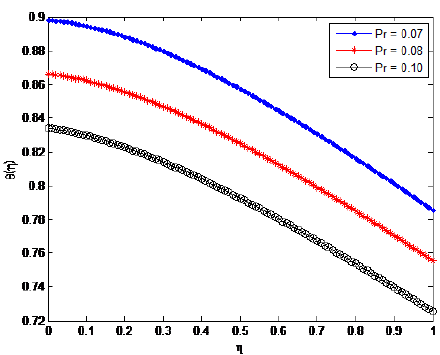
Figure 15. Influence of Prandtl number on dimensionless temperature profile